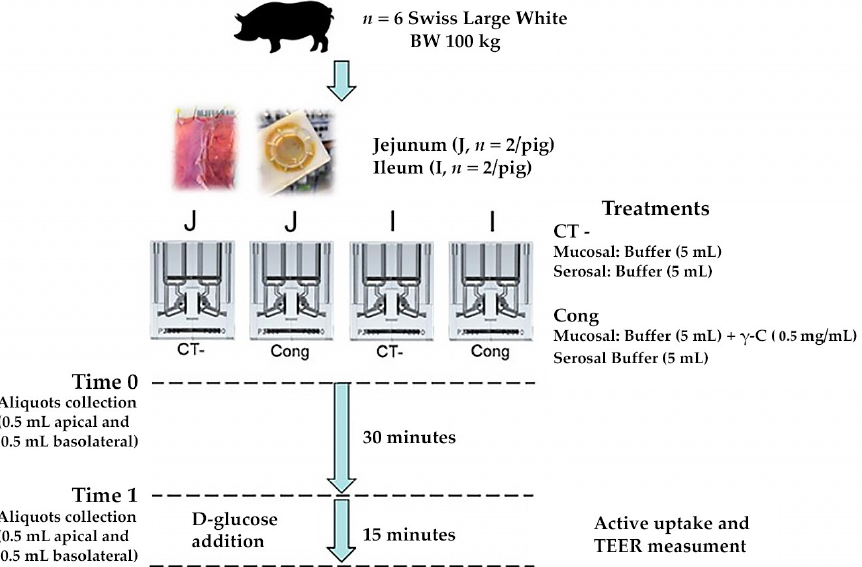
Figure 1. Study design of Ussing chamber experiments by using jejunum and ileum segments obtained by finishing pigs.